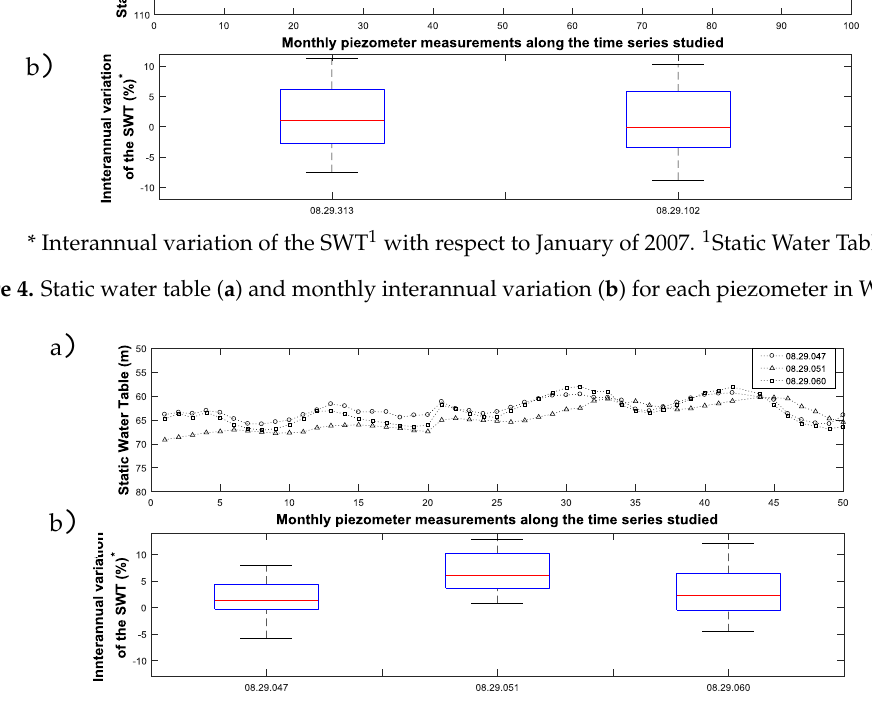
* Interannual variation of the SWT with respect to January of 2007 Figure 5. Static water table ( a ) and monthly interannual variation ( b ) for each piezometer in WUA B.